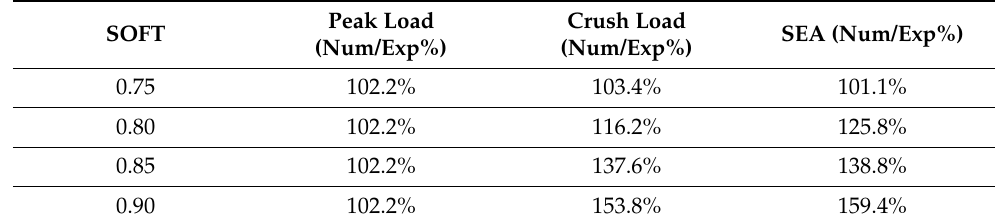
Table 4. The parametric study shows the effect of SOFT in MAT54 on the peak load, crush and SEA of the circular tube